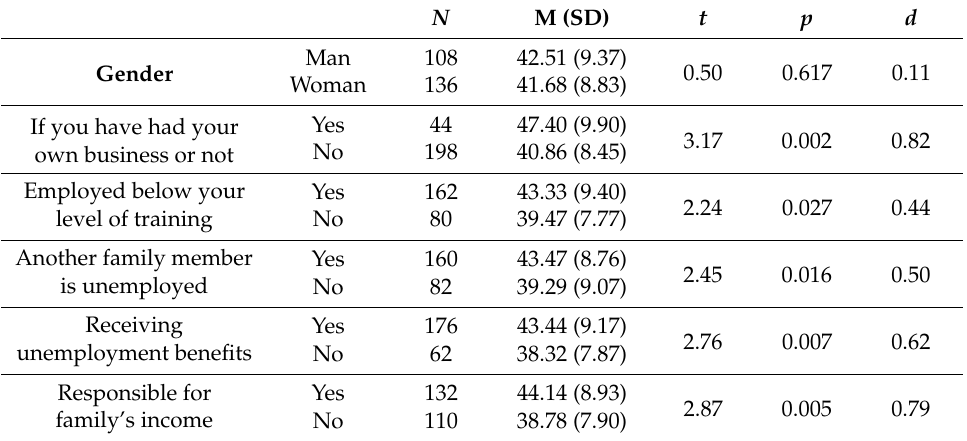
Table 2. Means, SD, T -test independent samples and effect size of self-rating depression scale